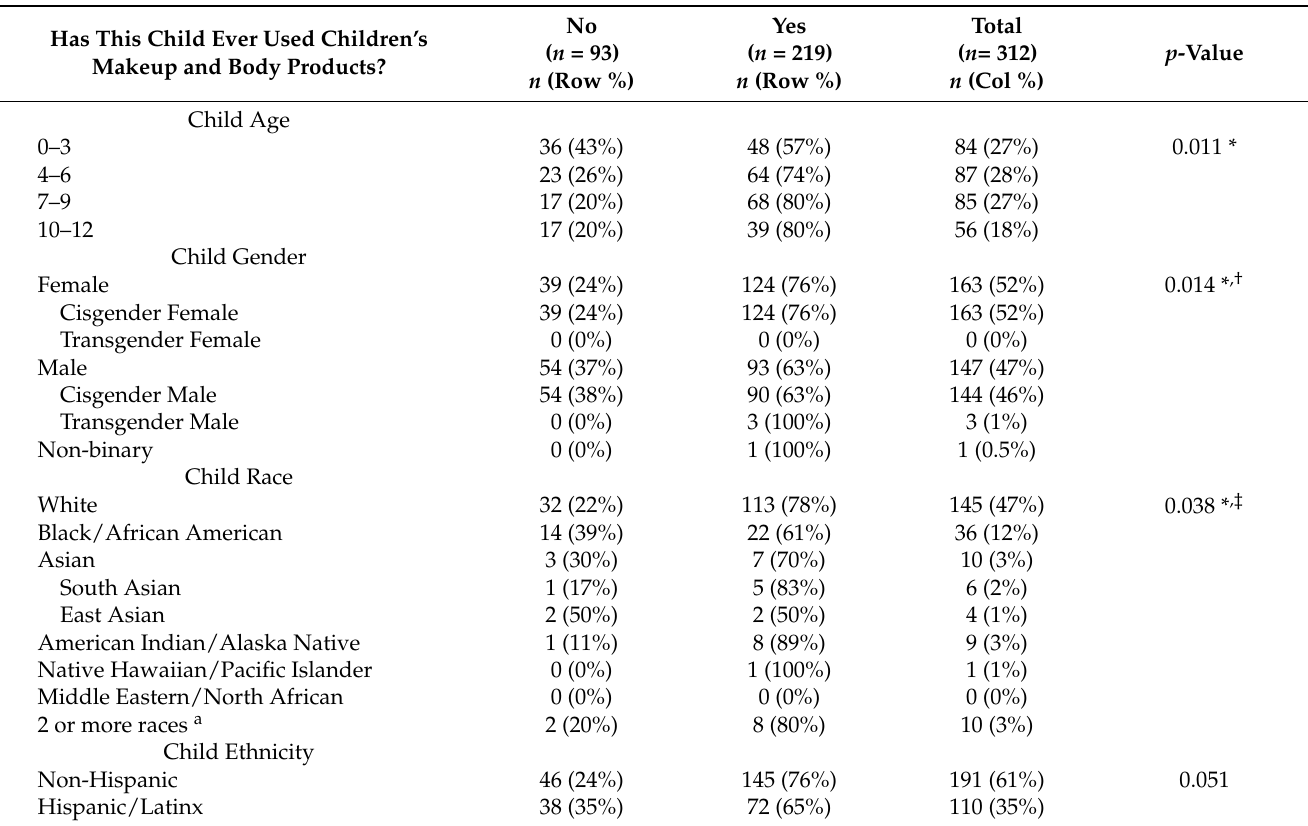
Table 2. Child characteristics by CMBP